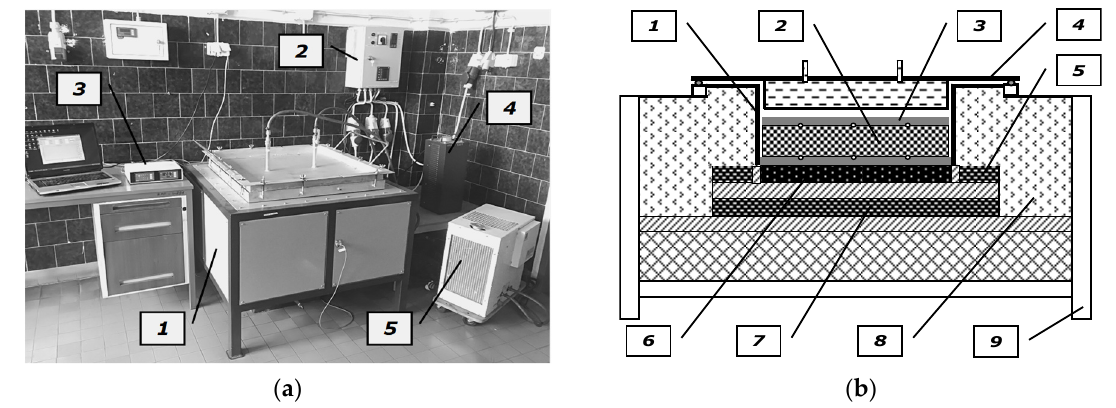
Figure 2. Testing stand: ( a ) general view: 1—heating chamber, 2—control unit of main and guarded heaters, 3—data logger with temperature meter, 4—autotransformer, 5—unit of cooling system; ( b ) scheme of the heating chamber: 1—retort with a hot plate, 2—investigated sample, 3—cold plate, 4—heating chamber cover with a cooler, 5—side guarded heater, 6—main heater, 7—bottom guarded heater, 8—thermal insulation, 9—support structure.